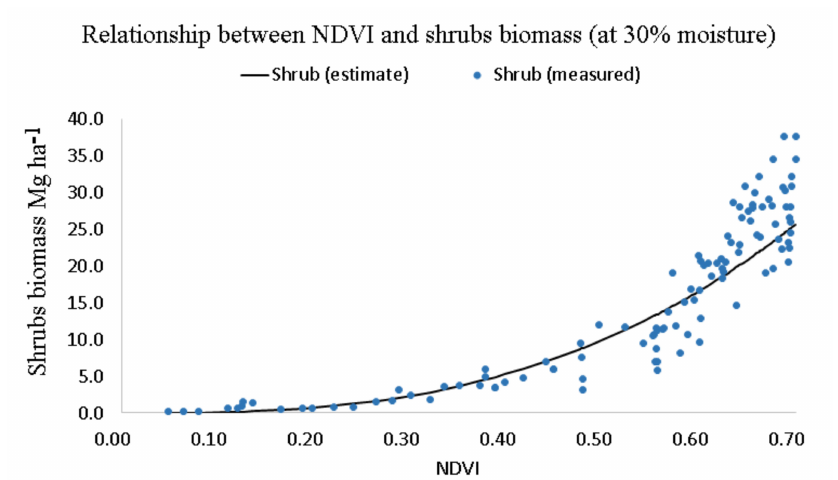
Figure 7. Relationship between NDVI and shrub biomass.